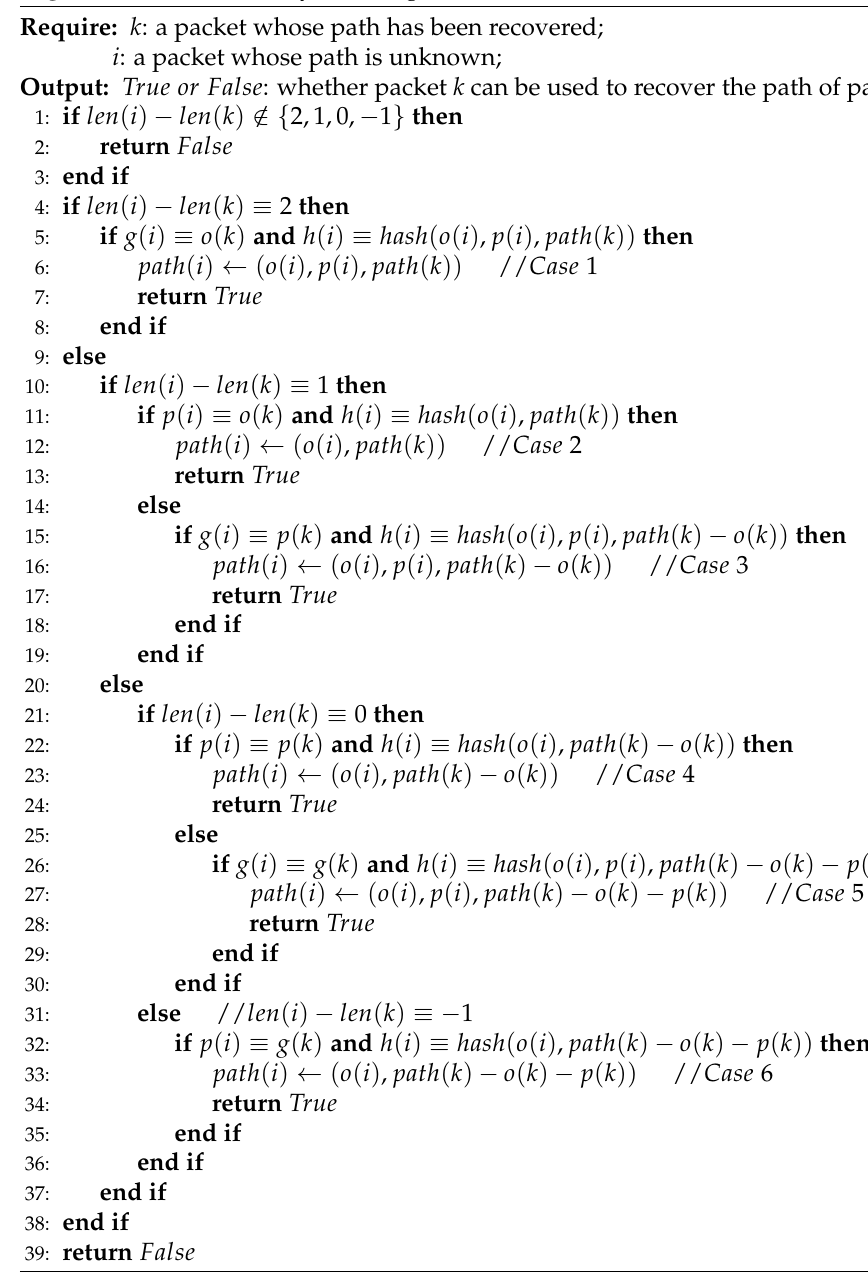
Algorithm 1 The Recovery Core